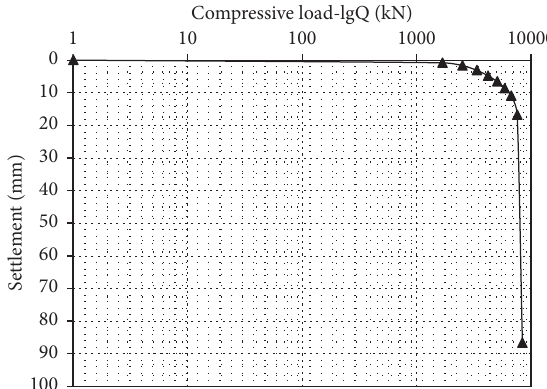
Figure 23: s-lgQ curves of P12.